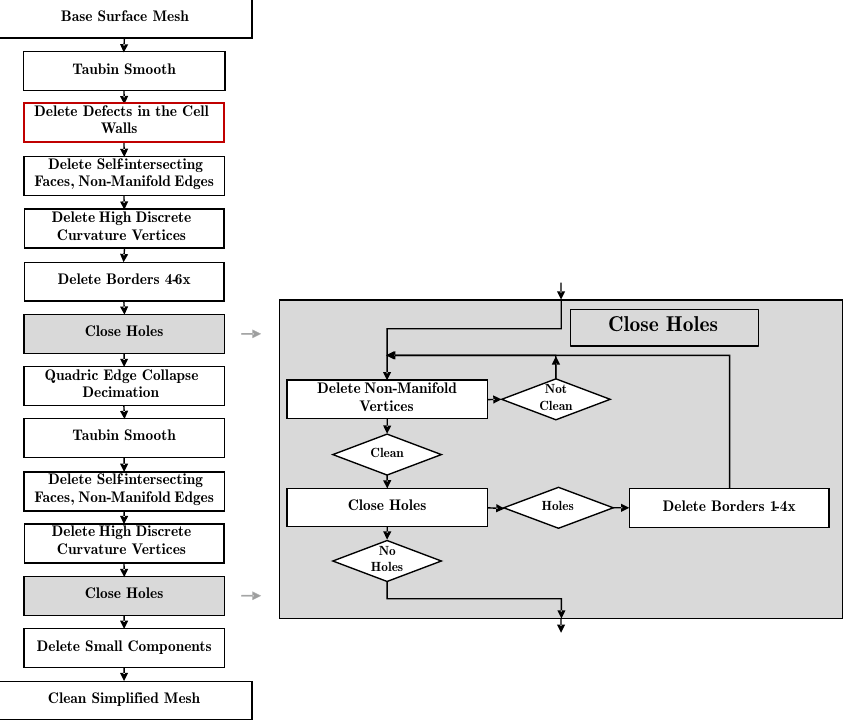
Figure 8. Procedure pipeline. The step represented in red is only added for Procedure 2 (clean small defects and